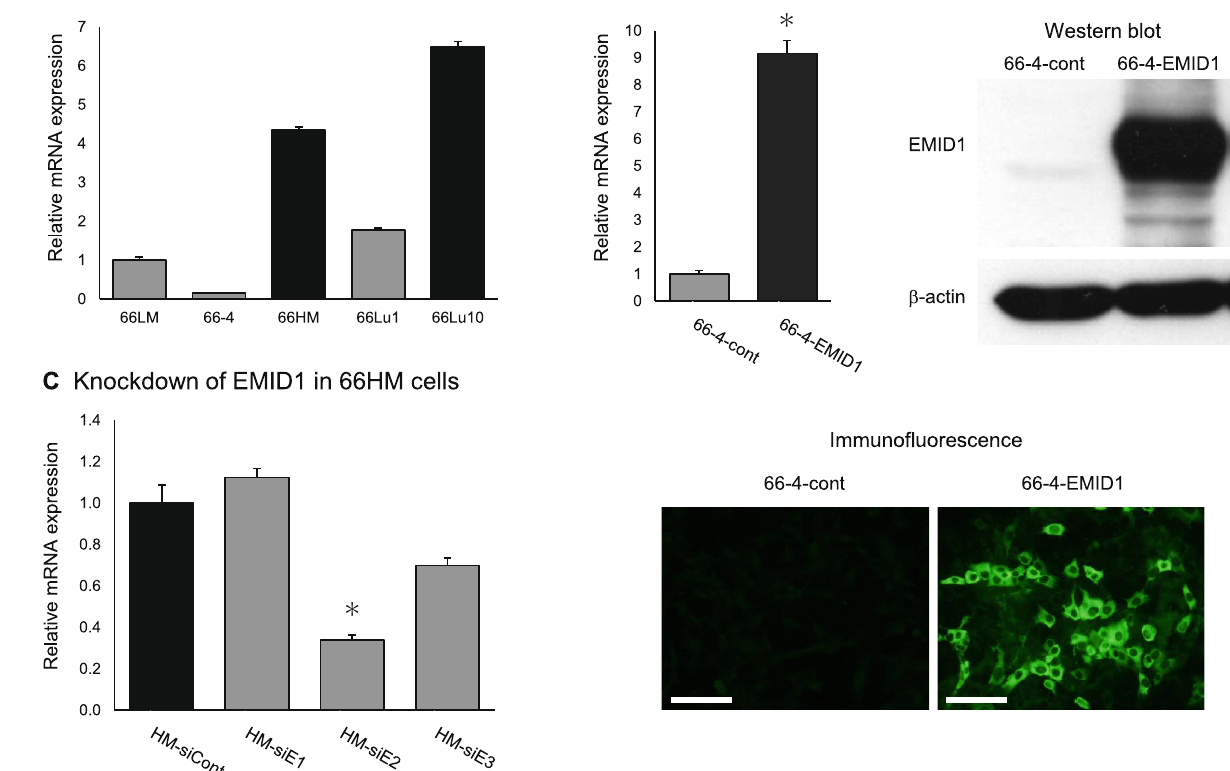
Figure 1. EMID1 expression in mouse cell lines. ( A ) Emid1 mRNA expression in vitro measured with real-time qRT-PCR. Error bars, ± standard deviation (SD) (n = 3). ( B ) Effect of stable transfection of the Emid1 expression vector on 66–4 cells. Overexpression of EMID1 was confirmed with real-time qRT-PCR (upper left), western blotting (upper right), and immunofluorescence (bottom). Error bars, ± SD (n = 3). * P < 0.05. Scale bar, 100 μm. ( C ) Knockdown effect of siRNAs for Emid1 on 66HM cells. Relative mRNA levels of the transfectants with specific siRNAs targeting three different sequences (siE1, siE2, and siE3) were measured with real-time qRT- PCR. Error bars, ± SD (n = 3). * P <